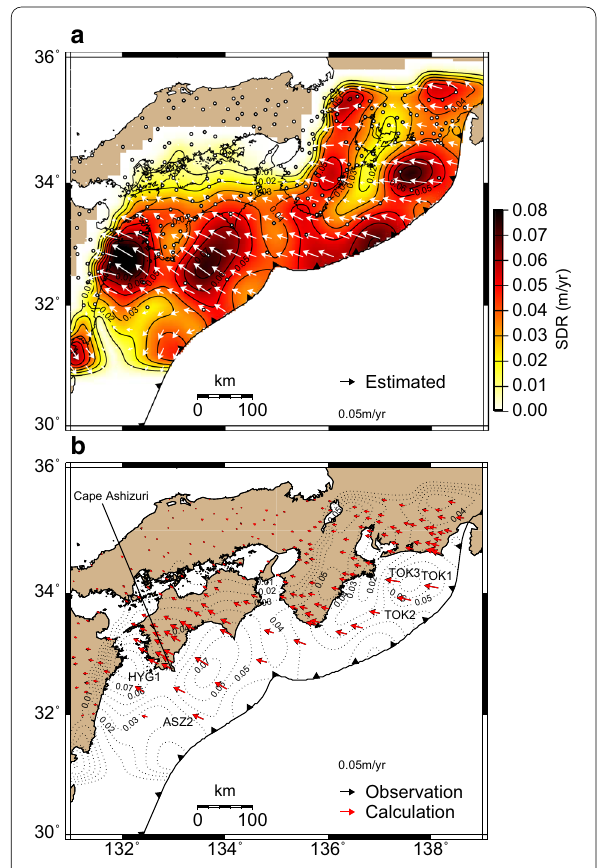
Fig. 6 SDR distribution estimated using the GF library. a Color contour and vectors of estimated SDR. The white dots denote the location of the observation. b Comparison of observed and calculated velocity in the observation stations. Dotted contour lines denote the norm of the estimated